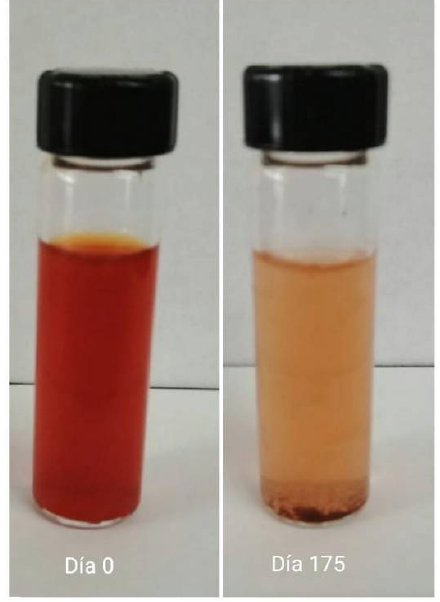
Figure 6. Photographs of GA-COO-SeNPs over 175 days period of storage. The left sample was taken immediately after synthesis (day 0).